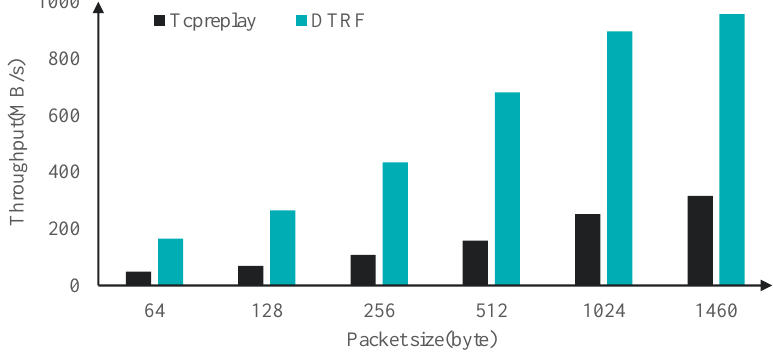
Figure 6. Throughput comparison.